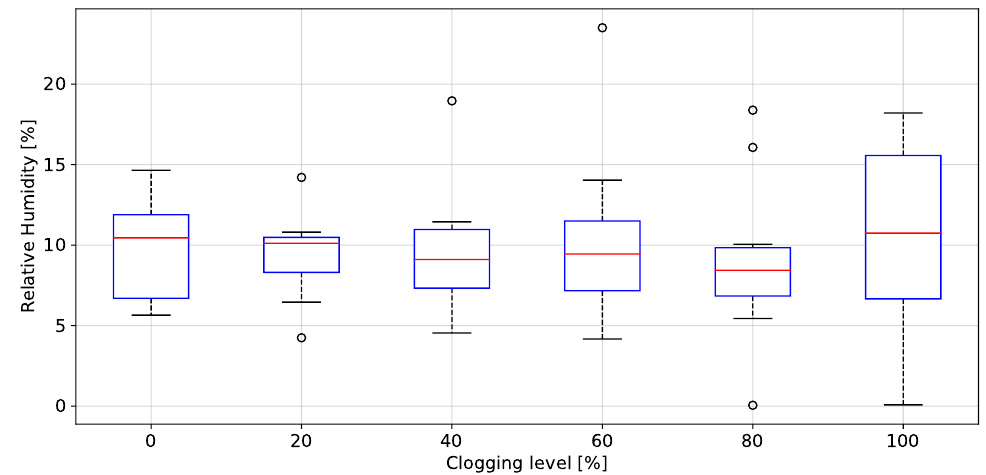
Figure 20. Peak to peak values of relative humidity as a function of the clogging level.